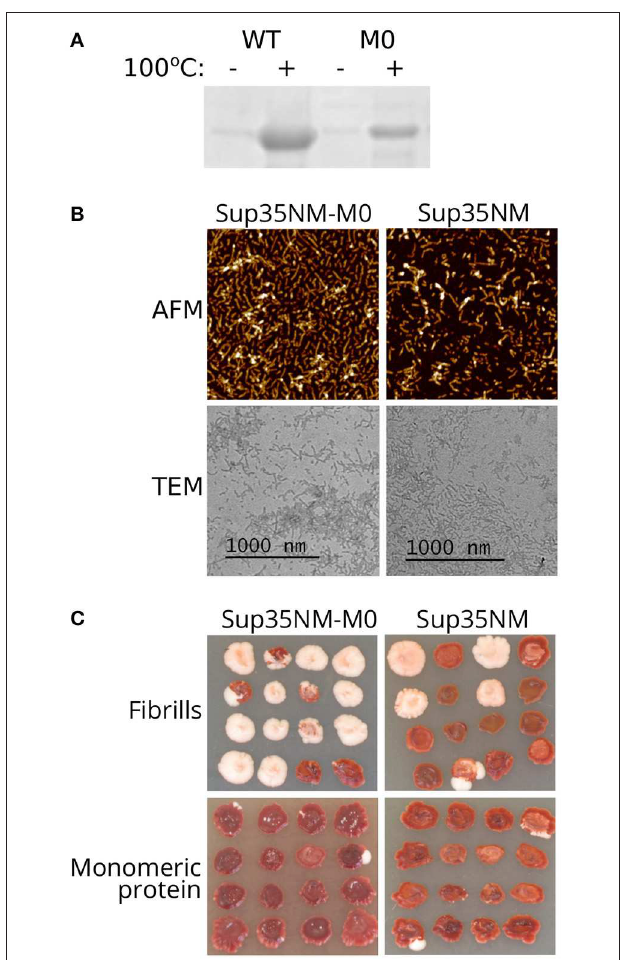
FIGURE 3 | Sup35NM-M0 forms infectious amyloid aggregates. (A) Result of Coomassie staining of the gel after SDS-PAGE analysis of Sup35 fibrils formed in vitro . Sup35-M0 forms SDS-resistant aggregates similar to wild-type Sup35. (B) AFM and TEM images of fibrils formed by Sup35NM or Sup35NM-M0. (C) Phenotype of [ psi – ][ pin – ] strain (2-OT56) transformed with fibrillar or monomeric proteins on 1/4 YEPD (16 independent transformants are shown for each case, images were taken after 5 days of incubation). The appearance of [ PSI + ] phenotype (white color) after protein transformation suggested infectious properties of the